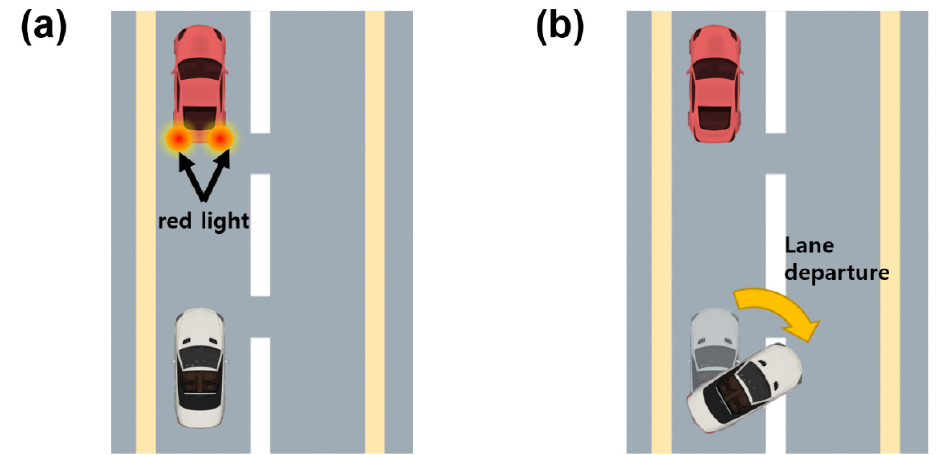
Figure 1. Schematic diagram of two types of unexpected situations. Participants always drive white cars on two-lane roads along with red cars ahead. ( a ) Sudden stop; ( b ) Lane